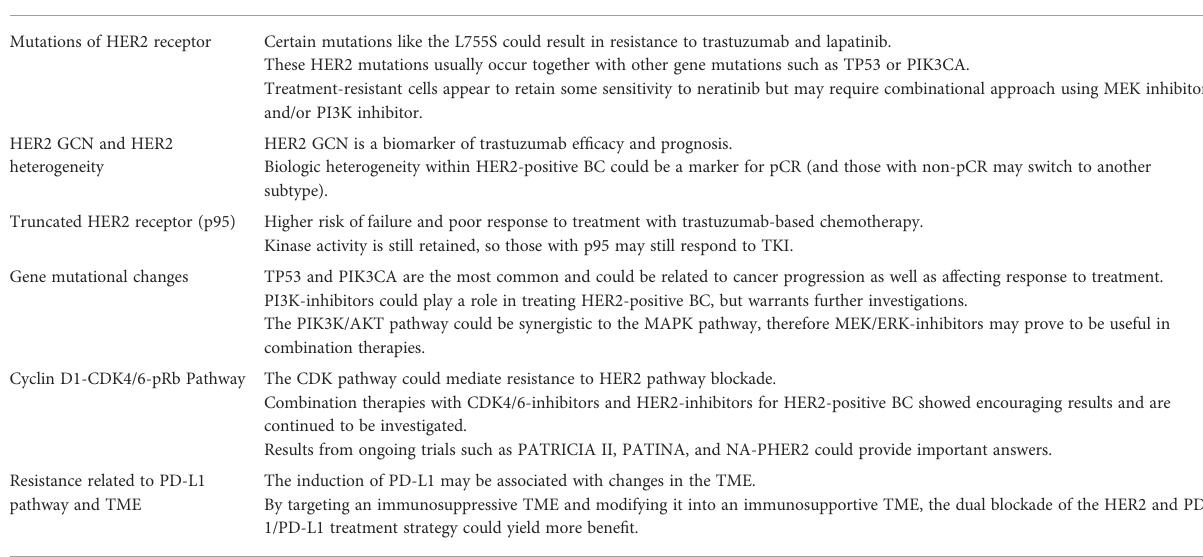
TABLE 1 Clinical implications of factors affecting metastasis and drug resistance in her2-positive breast cancers.